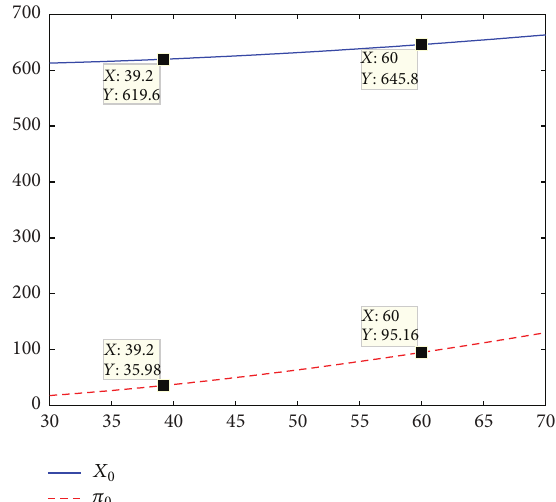
Figure 1: The influence of initial stock price.